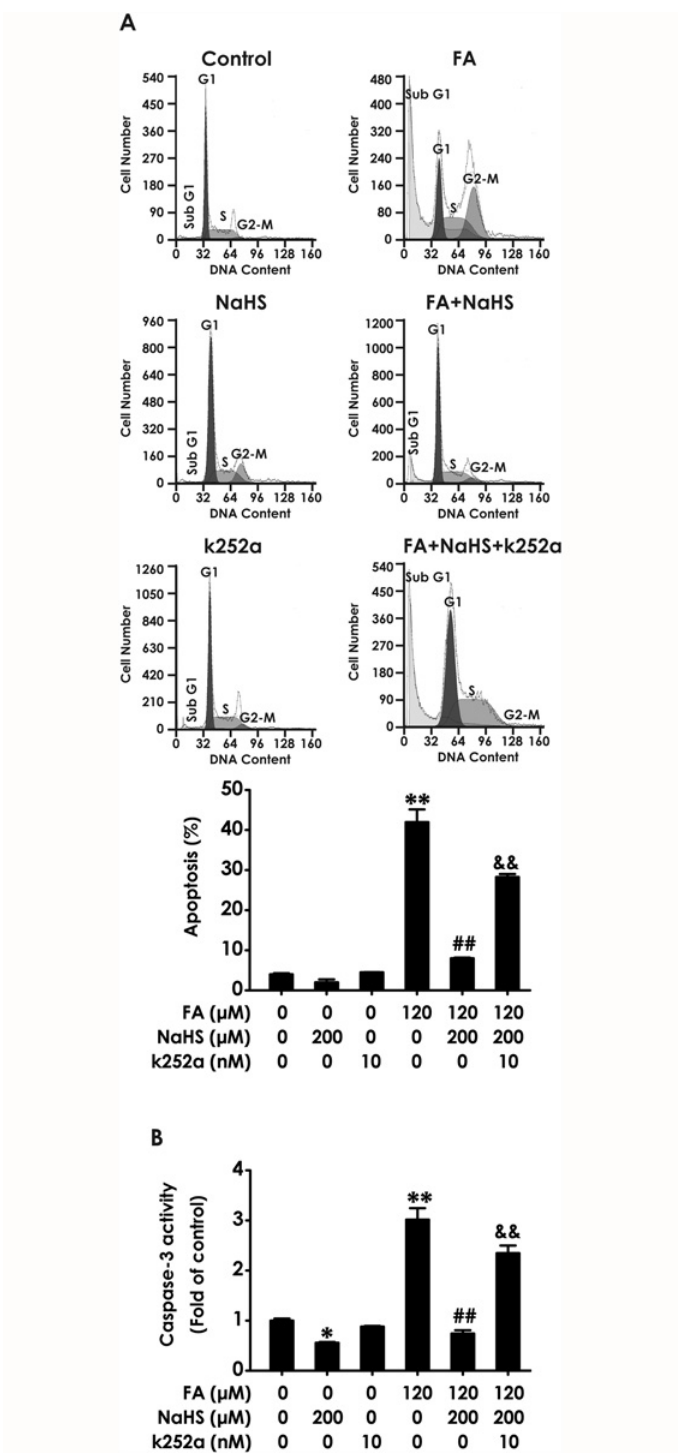
Fig 5. Effect of K252a on H 2 S-induced protection against formaldehyde-elicited apoptosis in PC12 cells. PC12 cells were preincubated with K252a (10 nM) for 30 min before pretreatment with NaHS (200 μ M) for 30 min, and then cotreated with formaldehyde (FA, 120 μ M) for 24 h. (A) The rate of apoptosis was assessed by flow cytometry after PI staining. (B) The activity of caspase-3 was determined by caspase-3 activity Elisa kit. Results were expressed as the mean ± S.E.M. of three independent experiments. * P <